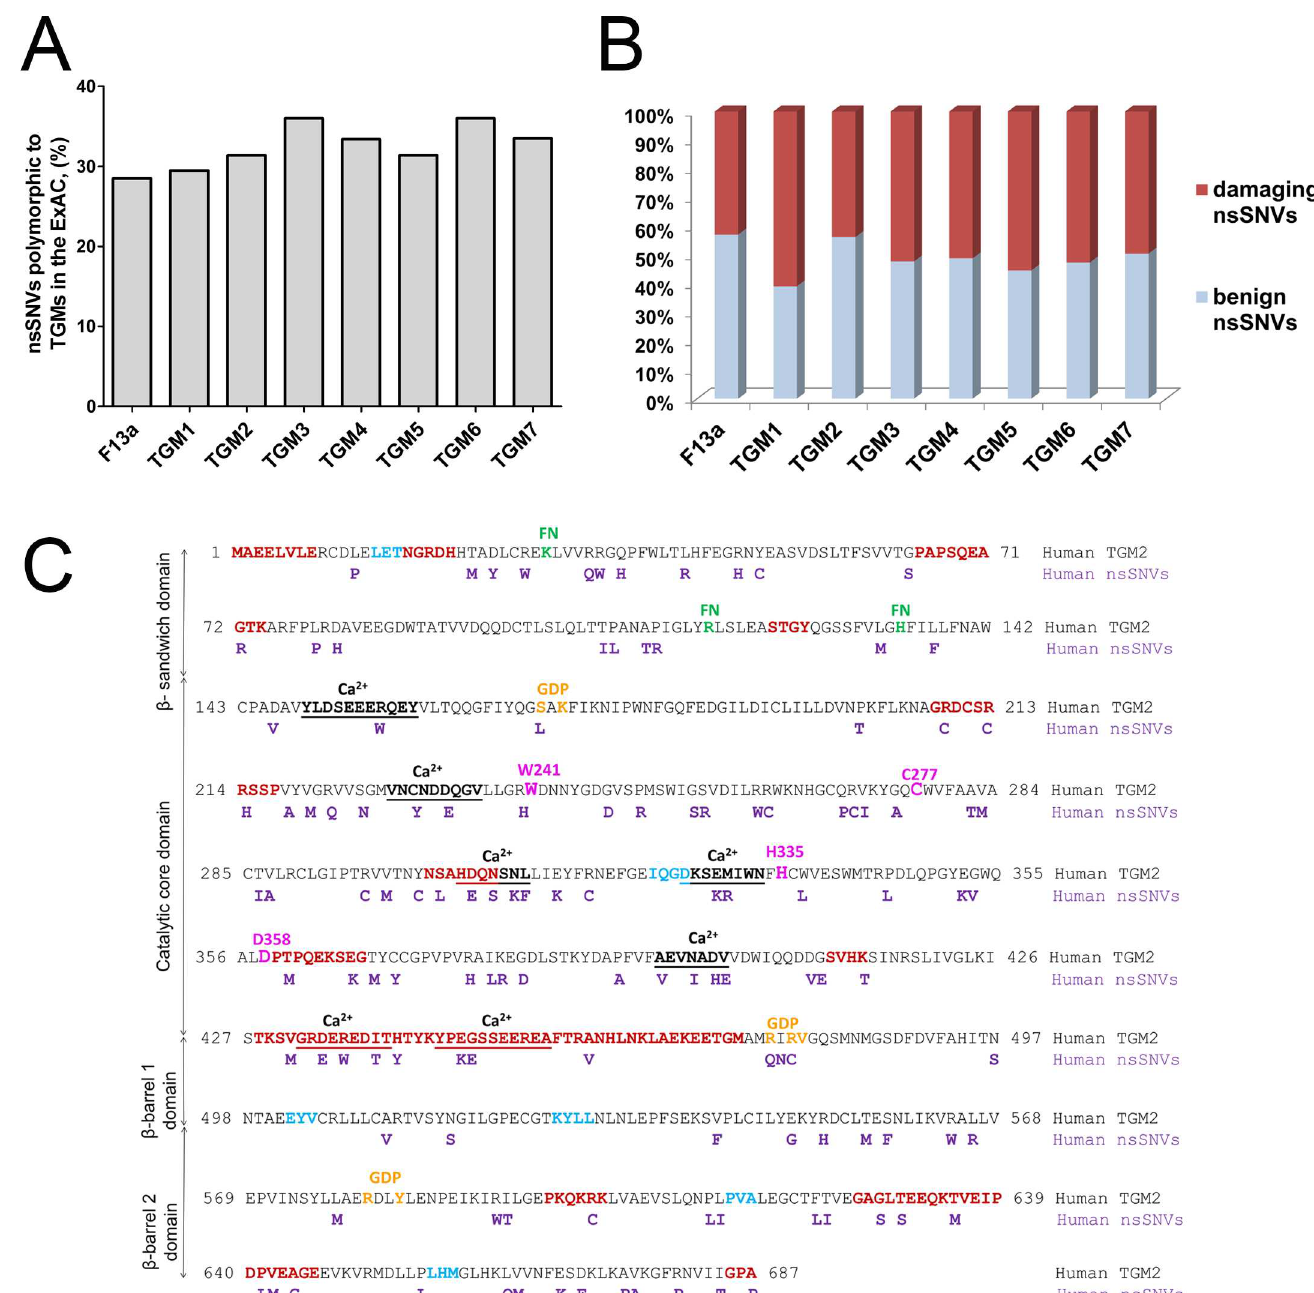
Fig 1. Analysesof non-synonymous variants in the transglutaminase family. (A) Amino acid residues polymorphic to non-synonymous variants. The percentage of polymorphic residues was obtained as a ratio of the total number of amino acid residuespolymorphic to nsSNVs and the sequencelength. The percentage of polymorphic residuesis shown. (B ) Proportion of damaging and benign non-synonymous variants by the PolyPhen score. Ratio of damaging nsSNVs: F13a (42.8%), TGM1 (60.8%), TGM2 (43.7%), TGM3 (52.2%), TGM4 (51%), TGM5 (55.3%), TGM6 (52.5%), and TGM7 (49.5%). (C) Location of damaging nsSNVs in amino acid sequence of TGM2 by PolyPhen/SIFT scores. Lane 1: sequence of human TGM2, Lane 2: damaging nsSNVs in humanTGM2. Functional regionsof human TGM2: Intrinsically disorderedregions(dark red) [4], amino acid clusters in light blue [30], fibronectinbindingsites (FN) (green)K30, R116, and H134 [31], GDP bindingresidues (orange)S171, K173, R476, R478, V479, R580, Y583 [32], catalytic residues (pink); non-canonical Ca 2+ -bindingsites: S4: 149–159,S1: 228–236, S3A: 305–311,S3B: 326–333, S2A: 395–401,S5: 432–440, and S2B: 445–455(underlined and bolded)[33]. Domainsof humanTGM2 are presented vertically: β sandwich(1–139), catalytic core (147–460), β -barrel1 (472–583), and β -barrel2 (584–687).